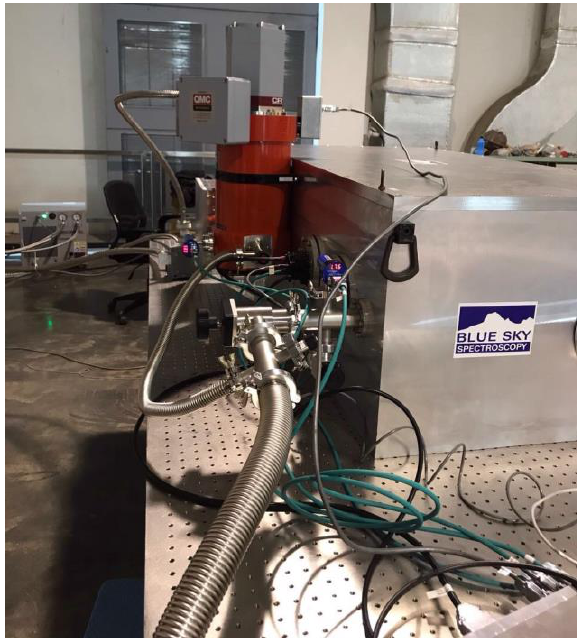
Fig. 2. Prototype Polarizing Fourier Transform Spectrometer being tested at ITER-India Lab